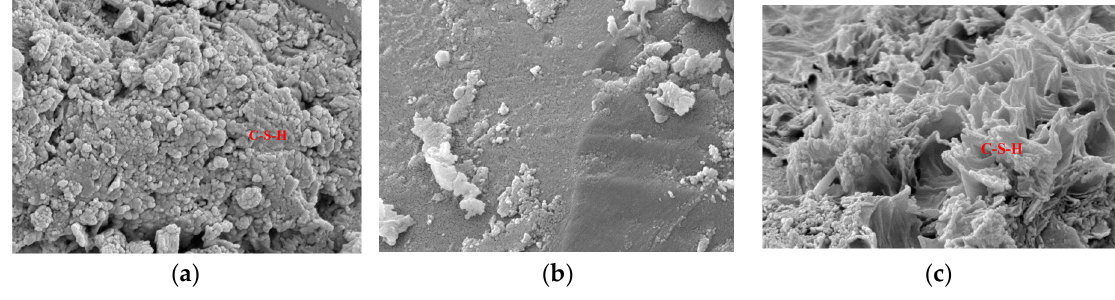
Figure 15. SEM image of mortar rubble ITZ. ( a ) SRB-1. ( b ) SRG-1. ( c ) SRL-1.